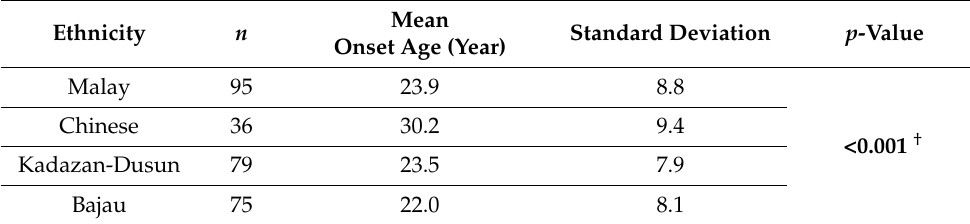
Table 5. The age of onset for METH exposure and dependence.